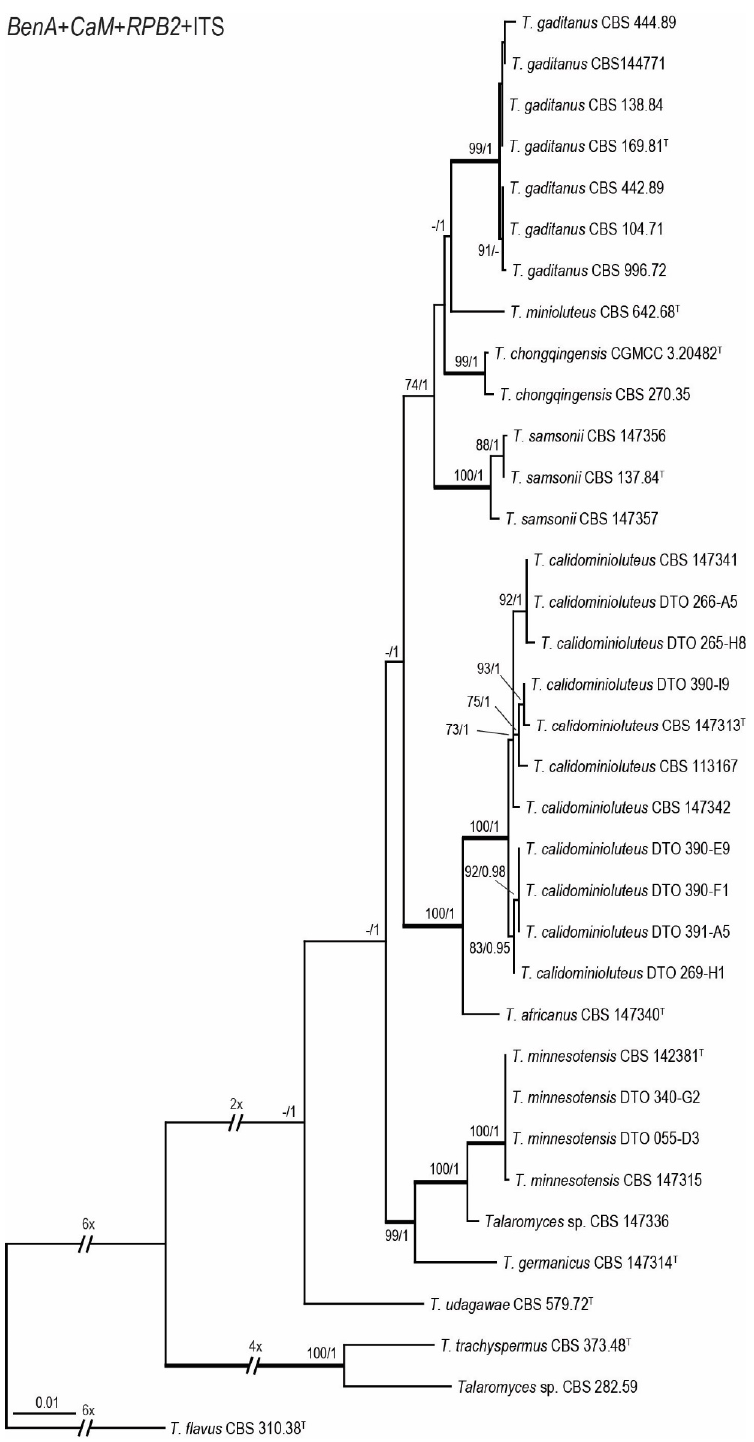
Figure 3. Maximum Likelihood (ML) tree inferred from the combined BenA , CaM , ITS and RPB2 sequence dataset depicting the relationship of T. minioluteus and phylogenetically related species. The BI posterior probabilities and ML bootstrap percentages are presented at the nodes (BS/PP) and the fully supported branches are thickened. Values less than 70% bs (ML) or less than 0.95 pp (Bayesian analysis) are indicated with a hyphen or not shown. The phylogram is rooted with T. flavus (CBS 310.38 T ), T. trachyspermus (CBS 373.48 T ) and Talaromyces sp. (CBS 282.59). T =